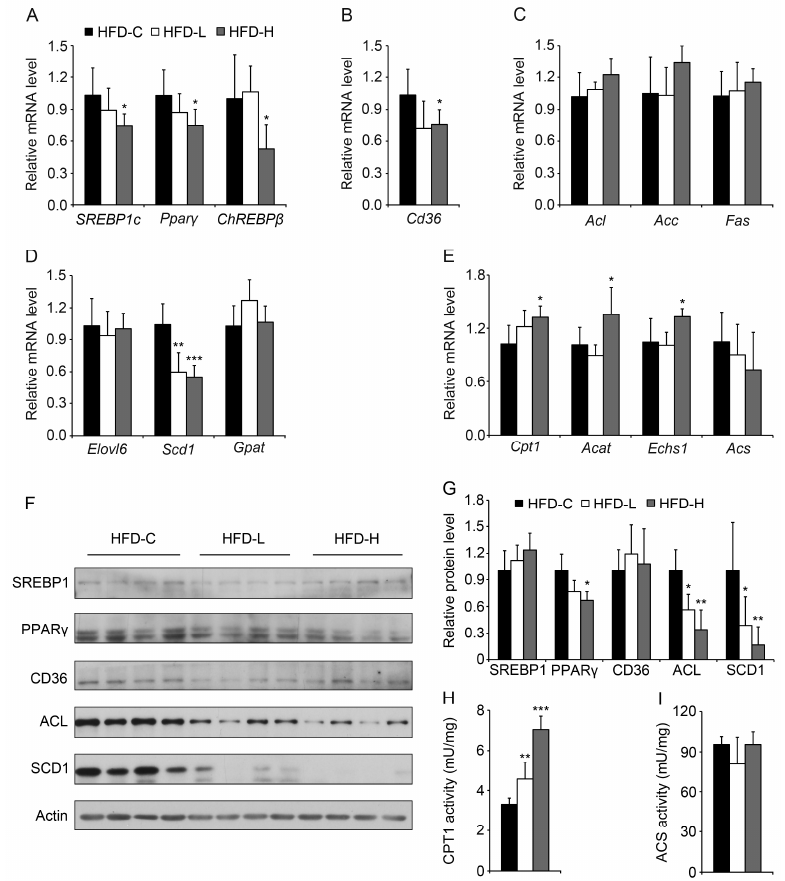
Figure 6. Hemin treatment decreases some hepatic genes involved in lipogenic regulation, fatty acid uptake and storage, and increases some hepatic genes involved in fatty acid oxidation. ( A ) Among the detected genes involved in lipogenic regulation, SREBP1c , Ppar γ and ChREBP β were downregulated by hemin in the liver of mice fed HFD as determined by quantitative PCR; ( B ) Cd36 was downregulated by hemin in the liver of mice fed HFD; ( C ) The detected genes responsible for fatty acid synthesis, including Acc , Acl and Fas , showed no significant change; ( D ) As for the detected genes related to fatty acid storage, Scd1 was markedly downregulated by hemin in the liver of mice fed HFD; ( E ) Among the detected genes involved in fatty acid oxidation, Cpt1 , Acat and Echs1 were upregulated by hemin in the liver of mice fed HFD. n = 6 for each group; ( F , G ) The protein levels of PPAR γ , ACL and SCD1 were were significantly downregulated by hemin in the liver of mice fed HFD; ( H , I ) The enzyme activity of CPT1 ( H ), catalyzing the rate-limiting step in β -oxidation of fatty acids, but not that of ACS ( I ), was markedly upregulated by hemin in the liver of mice fed HFD. * p < 0.05; ** p < 0.01; *** p < 0.001.